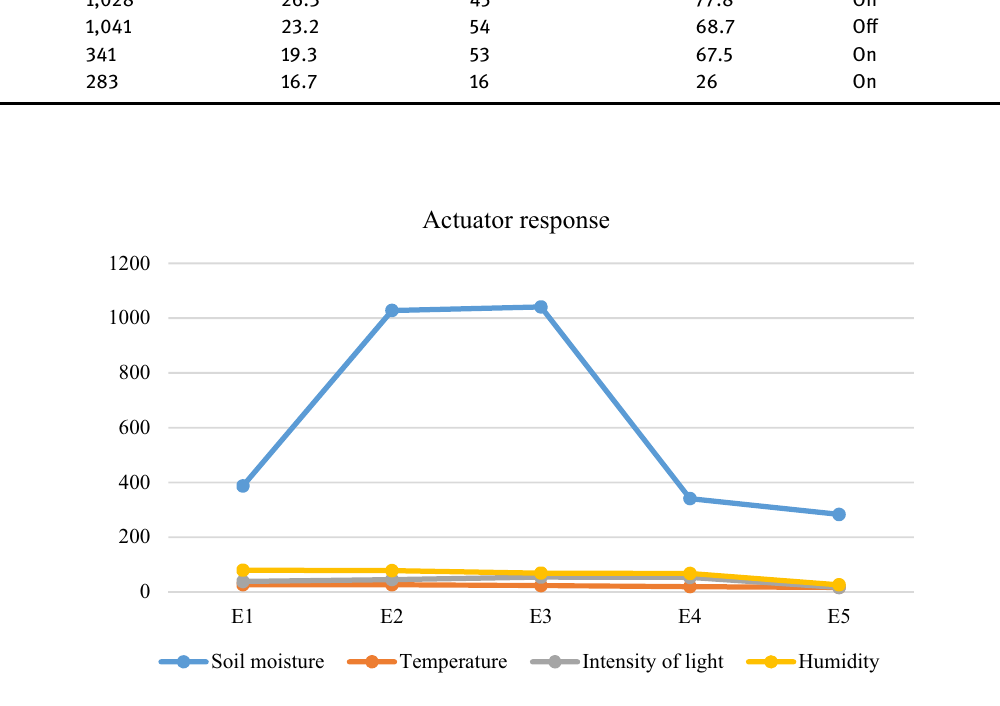
Figure 6: Actuator response for di ff erent